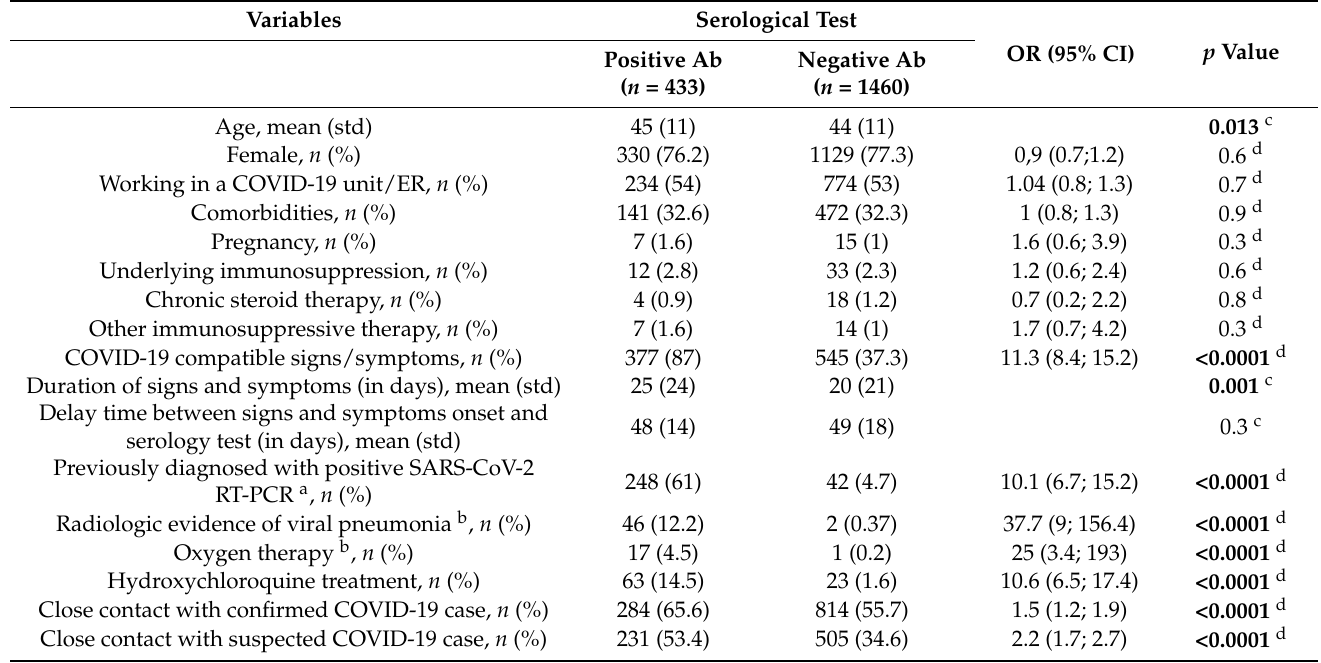
Table 2. Distribution and strength of association as odds ratios (OR) with 95% confidence interval (95% CI) of various variables with detectable SARS-CoV-2 IgG antibodies.